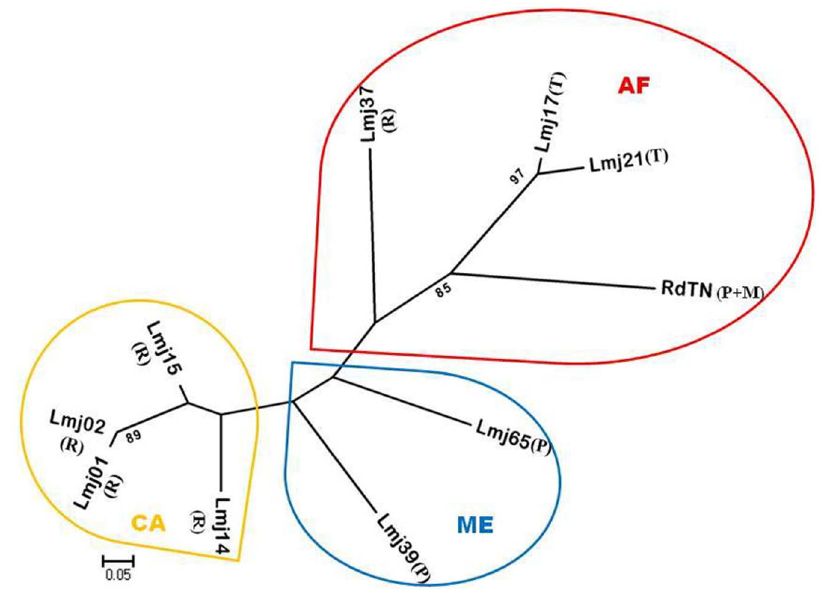
Figure 2. Neighbour-joining tree inferred from the Dps distances calculated for 55 L.major strains isolated from different rodents (40 Tunisian and 15 from other geographic origins) according to the 10 microsatellites analyzed. Strains isolated among P. obesus (P), M. shawi (M), Tatera sp. (T) and R. opimus (R) were classified into 10 genotypes Lmj01, Lmj02, Lmj14, Lmj15, Lmj17, Lmj21, Lmj37, Lmj39, Lmj65 (as described in[21]) and RdTN from Africa (AF), Middle East (ME) and Central Asia (CA). RdTN indicates the genotype obtained from Tunisian reservoirs. Results are shown as radial tree where the percentages (under 80%) with which a branch is supported in 1000 bootstrap replications are indicated.